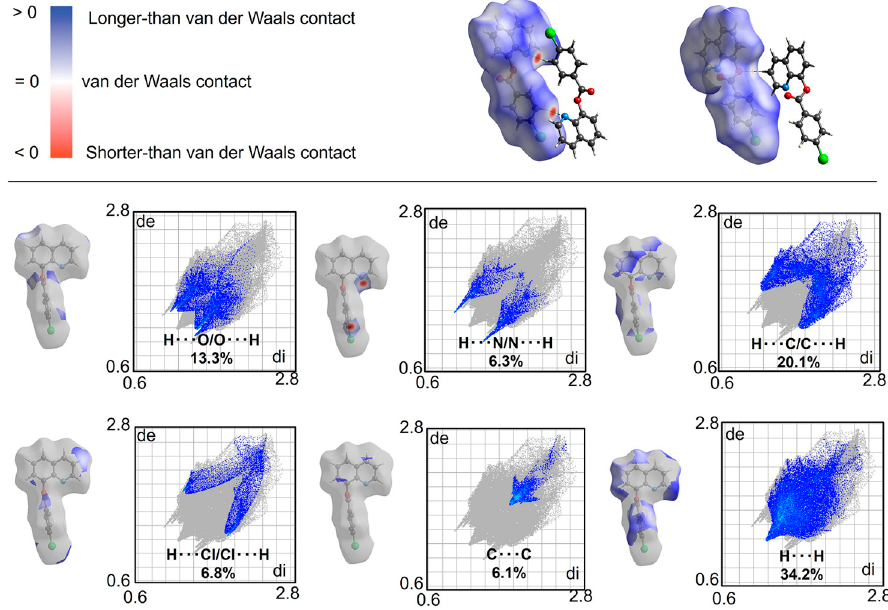
Figure 8. Hirshfeld surfaces mapped over d norm and 2D fingerprint plots including relative contributions (%) to the Hirshfeld surface area for the various close intermolecular contacts for compound 3 .